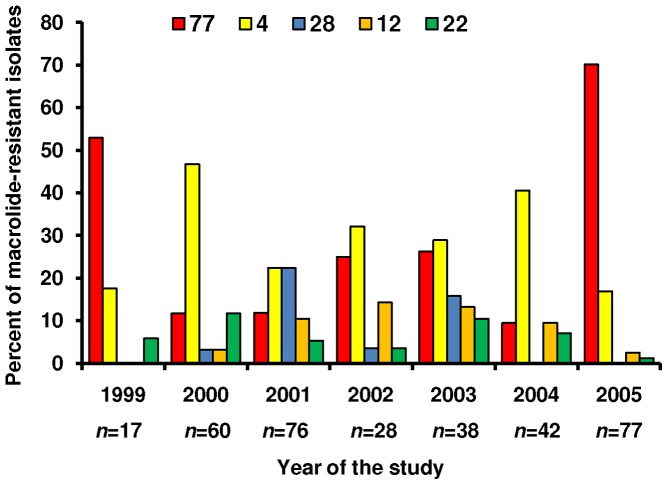
Macrolide-resistant group A streptococcal isolates.Annual frequencies of the 5 most common emm types. A significant yearly variation was observed in emm28 (P<0.001), emm77 (P<0.001) and emm4 (P<0.005).